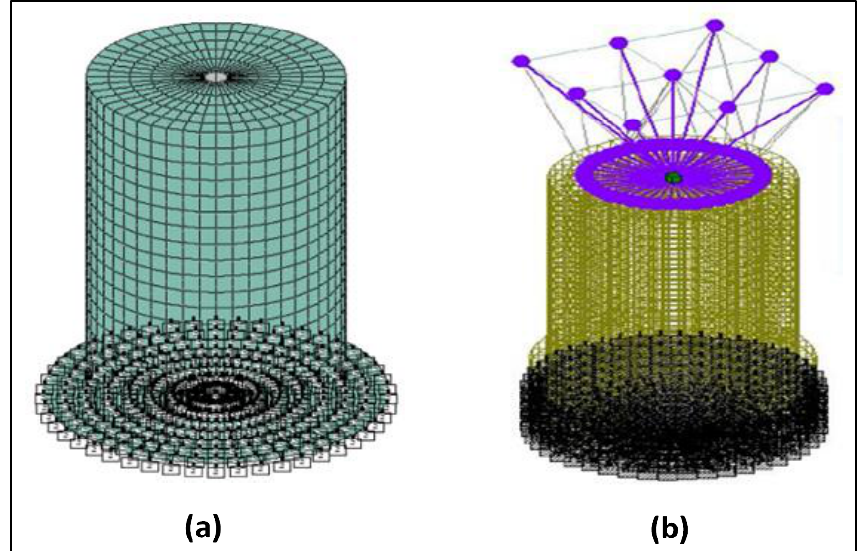
Figure 5. Analysis model for (a) Bare Pier (b) Pier with telescope as rigid links